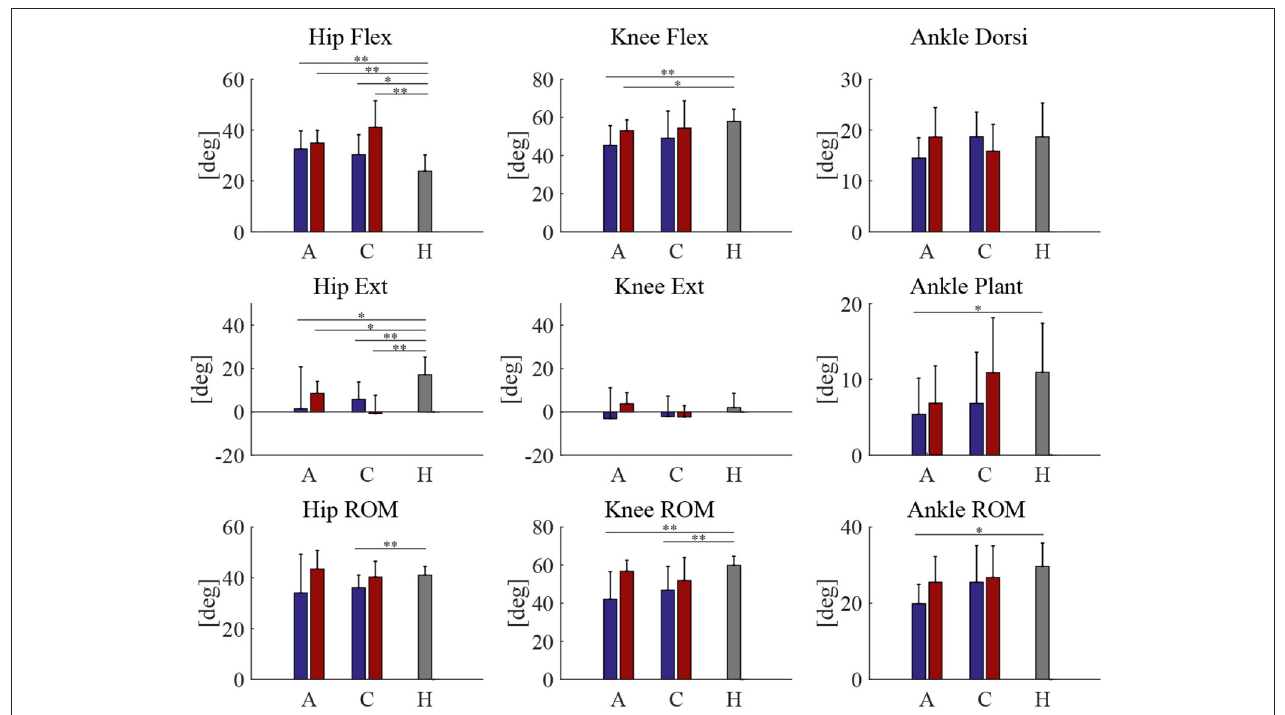
FIGURE 3 | Peak joint angles | A, C, H is stands for acute, chronic, and healthy, respectively. Blue and red bars represent pre and post HAL intervention, respectively. ** P < 0.01, * P < 0.05, and no sign means P >